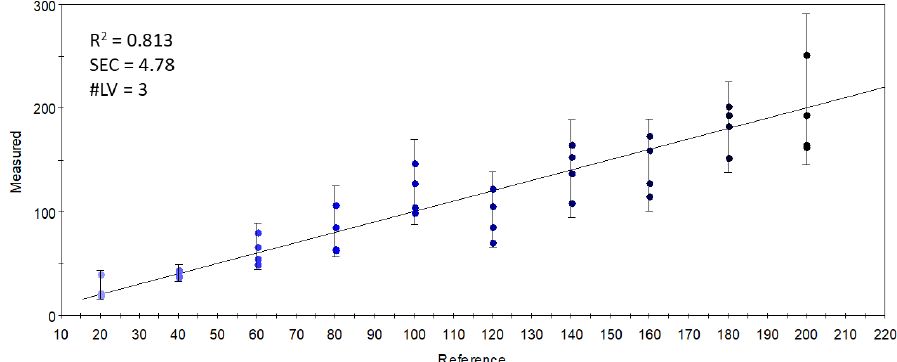
Figure 9. Y-fit of the PLSR calibration on the S17-P100 concentration (mg/10 g product) using data from the selected quantitative sensors (R 2 : determination coefficient; SEC: standard error of calibration; #LV: number of latent variables); the intensity of the colors from light blue to black along the Y-fit line represents the increase in concentration levels of the DHA supplementation.